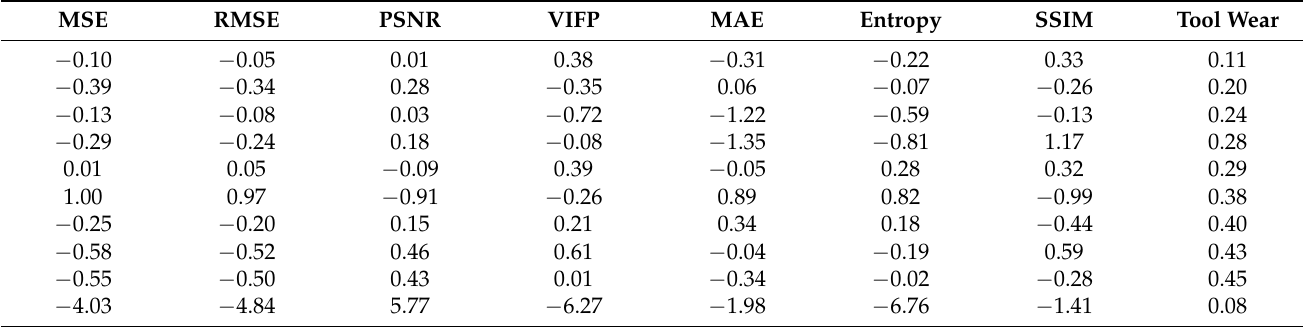
Table 4. Sample feature vector after